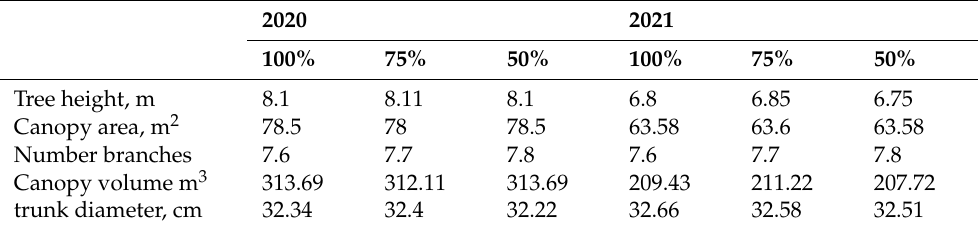
Table 4. Average tree height, trunk and canopy diameter, canopy volume, and number of branches of mature trees during 2020 and 2021 under different irrigation